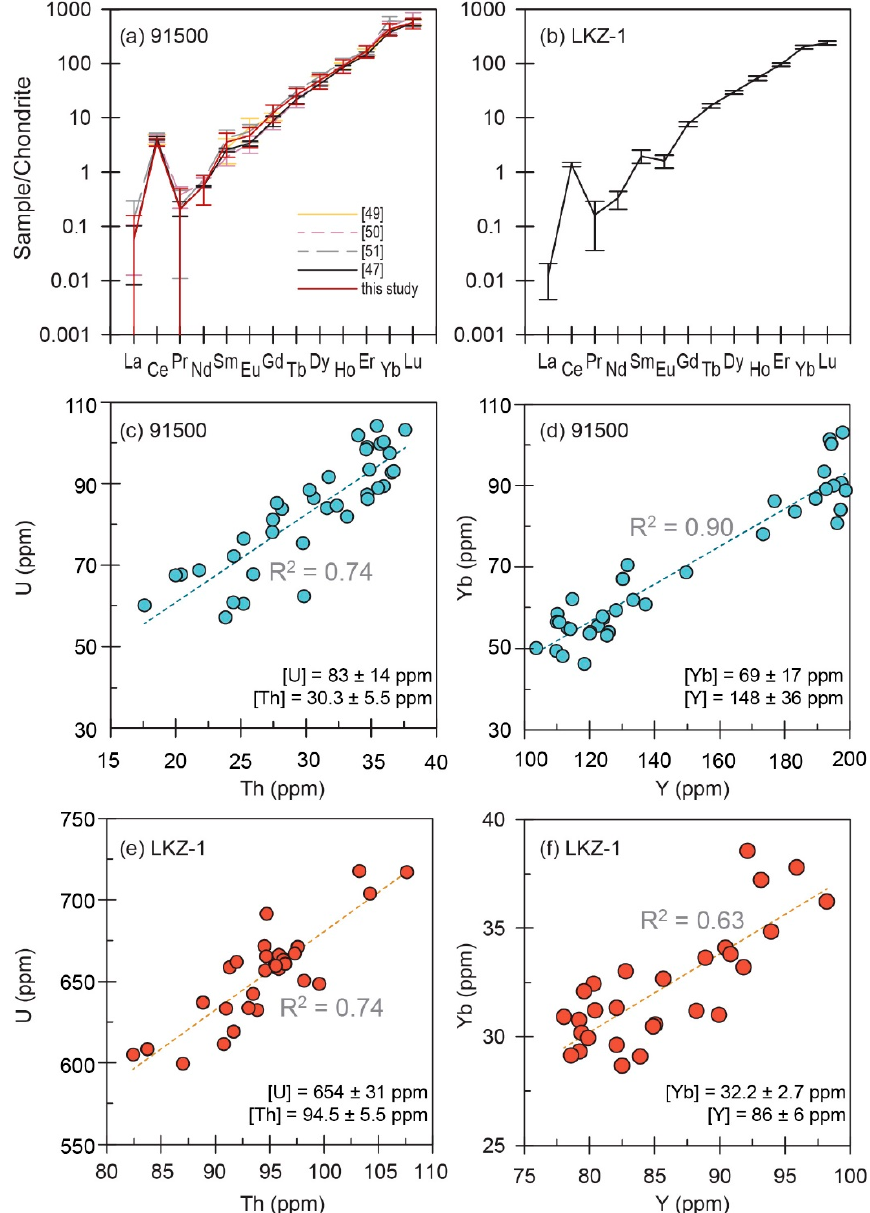
Figure 7. Chondrite-normalized REE patterns of 91500 ( a ) and LKZ-1 ( b ) zircons. Chondrite values were taken from McDonough and Sun (1995) [52]. Vertical error bars denote 1 standard deviation of our data, or uncertainties reported in previous works. ( c – f ) U vs. Th and Yb vs. Y variations for 91500 and LKZ-1 zircons.